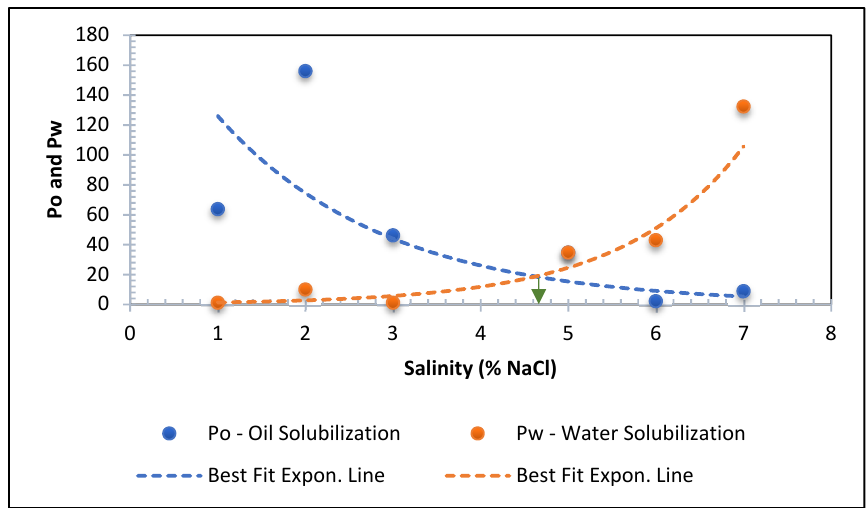
Table 4. APG surfactant and different concentration of formic acid. Figure 9. Optimum salinity determination. Figure 9. Optimum salinity determination. Sample No.